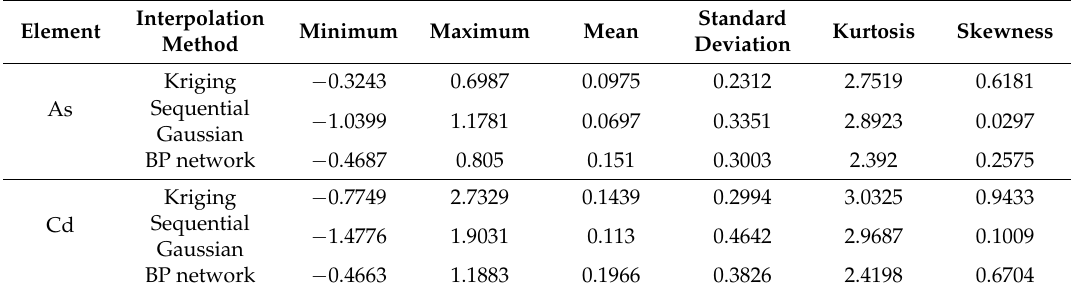
Table 2. Descriptive statistical analysis results of the As and Cd geo-accumulation